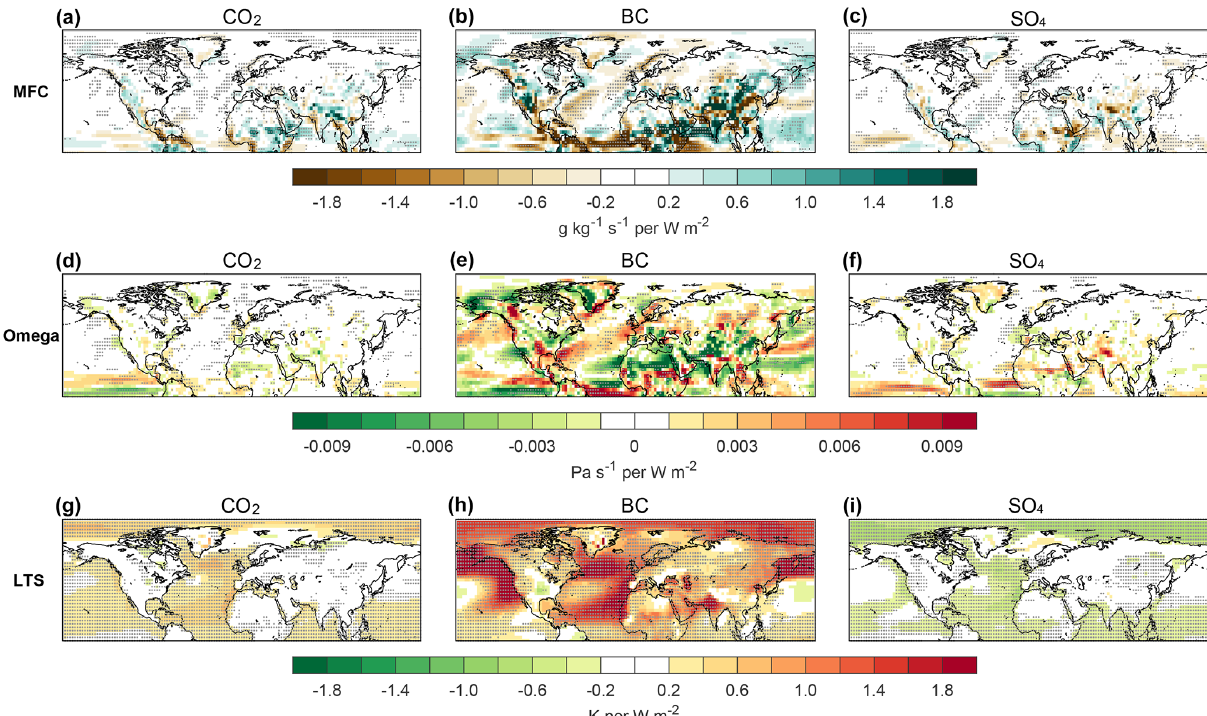
Figure 6. Same as Fig. 2, but for changes in moisture flux convergence (MFC, a–c ), vertical velocity (omega, d–f ), and lower tropospheric stability (LTS, g–i ) per unit forcing. For vertical velocity (omega), positive anomalies indicate the air is less convective. LTS is calculated as the difference of potential temperature between 700hPa and the surface. Positive LTS anomalies in (g–i) indicate stronger inversion or a weaker lapse rate.